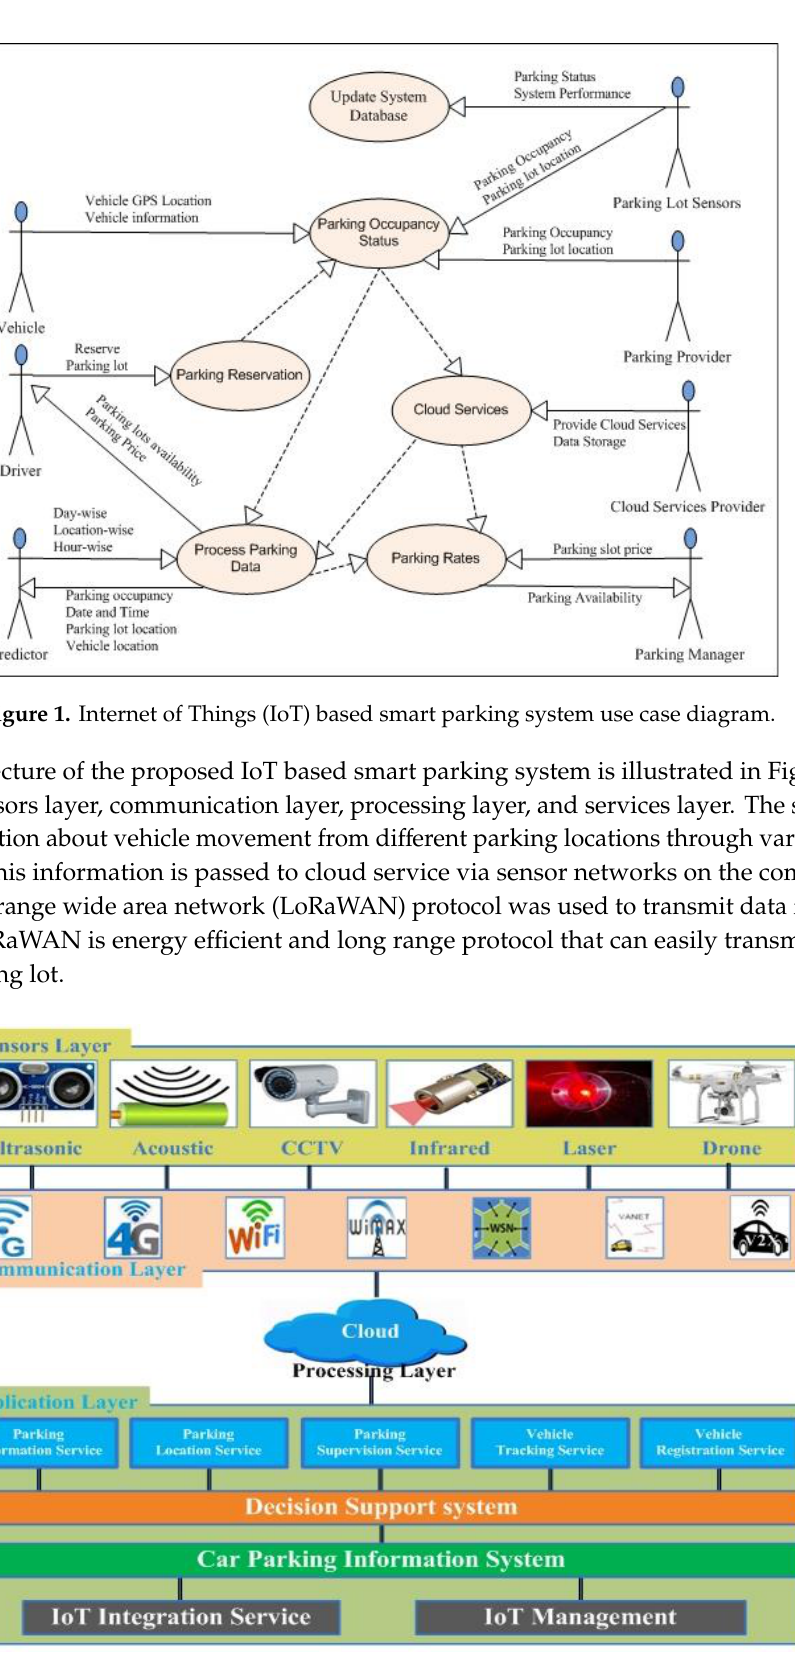
Figure 2. Sensors Network-based decision support system for car parking availability prediction.